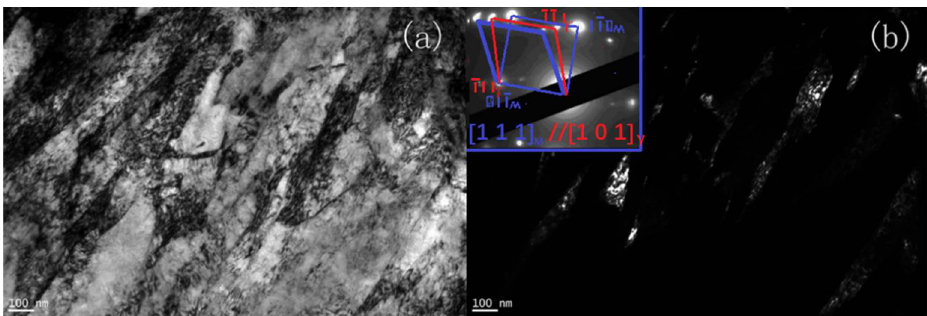
Figure 6. Bright field image ( a ) and dark field image ( b ) of the quenching-partitioning-tempering sample.